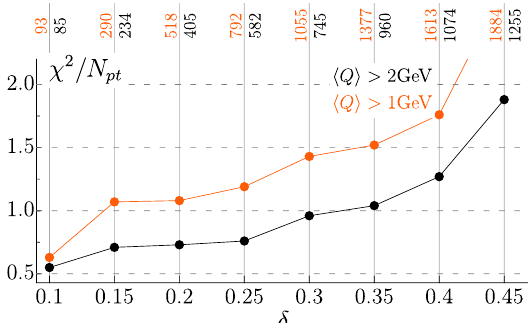
Figure 11 . The value of (cid:31) 2 =N pt depending on the cuts of the data for SIDIS. The theory prediction is calculated with NNPDF31 & DSS set at NNLO. The numbers on vertical lines shows the number of points in the cut data